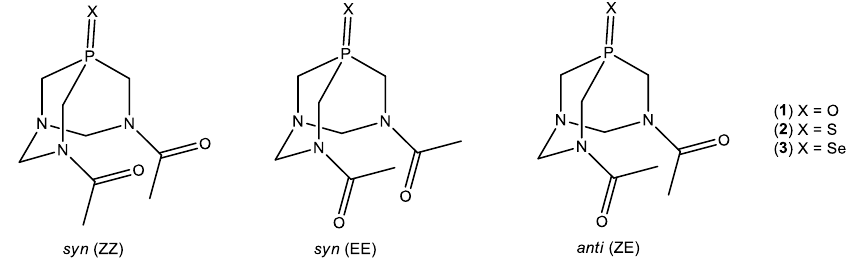
Figure 2. Isomeric forms of compounds 1 – 3 .